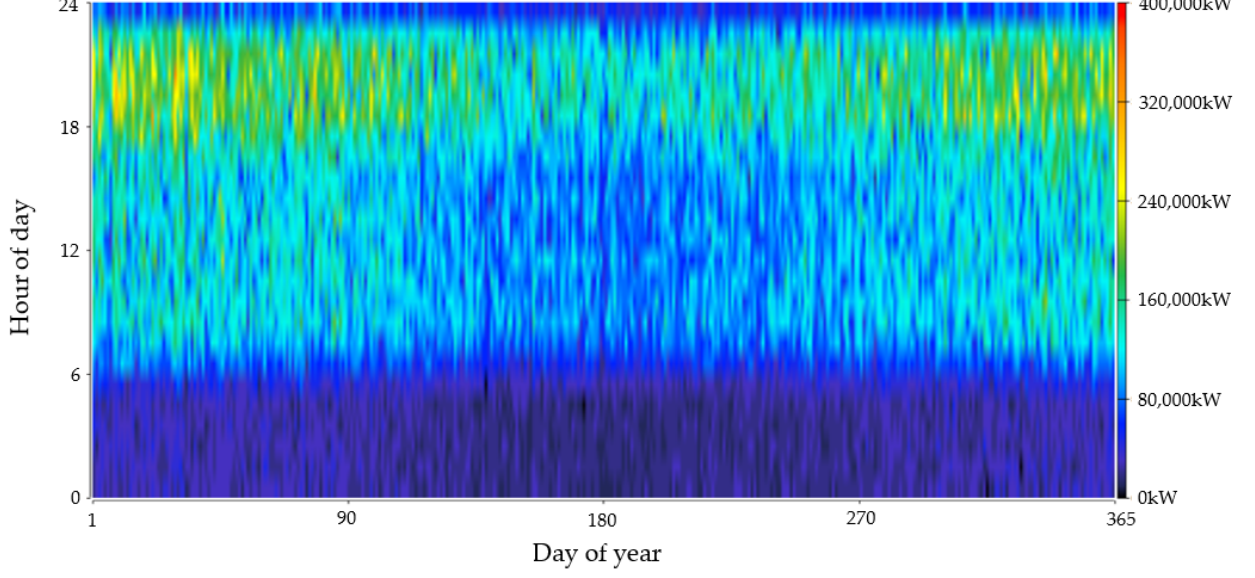
Figure 7. Data map of hourly electricity consumption for Portsmouth.